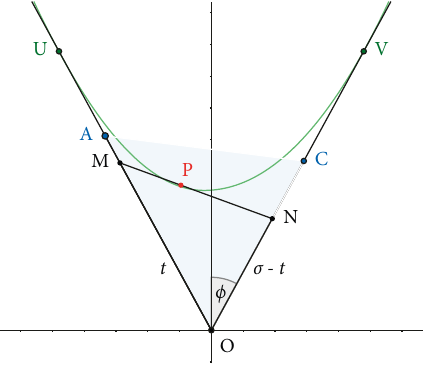
Figure 3: The single angle envelope E ( 2 ϕ , σ )